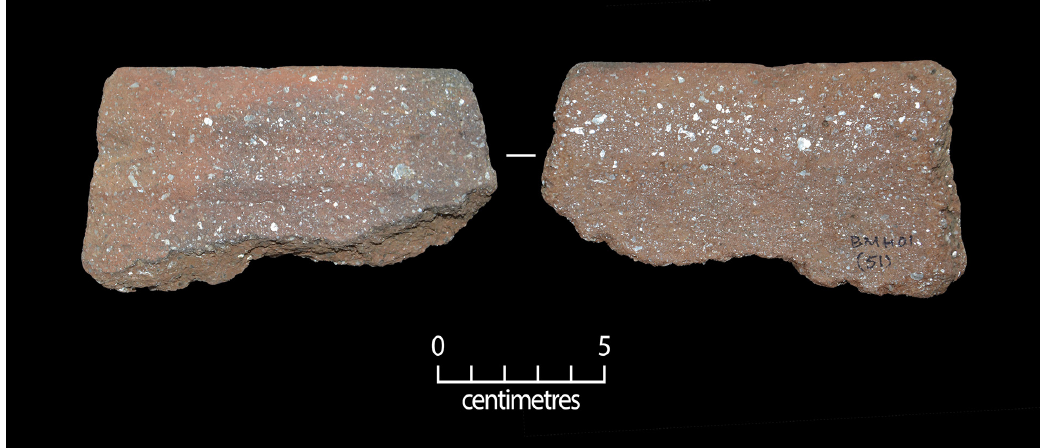
Figure 10: External and internal surface of a Class 4 variant 3